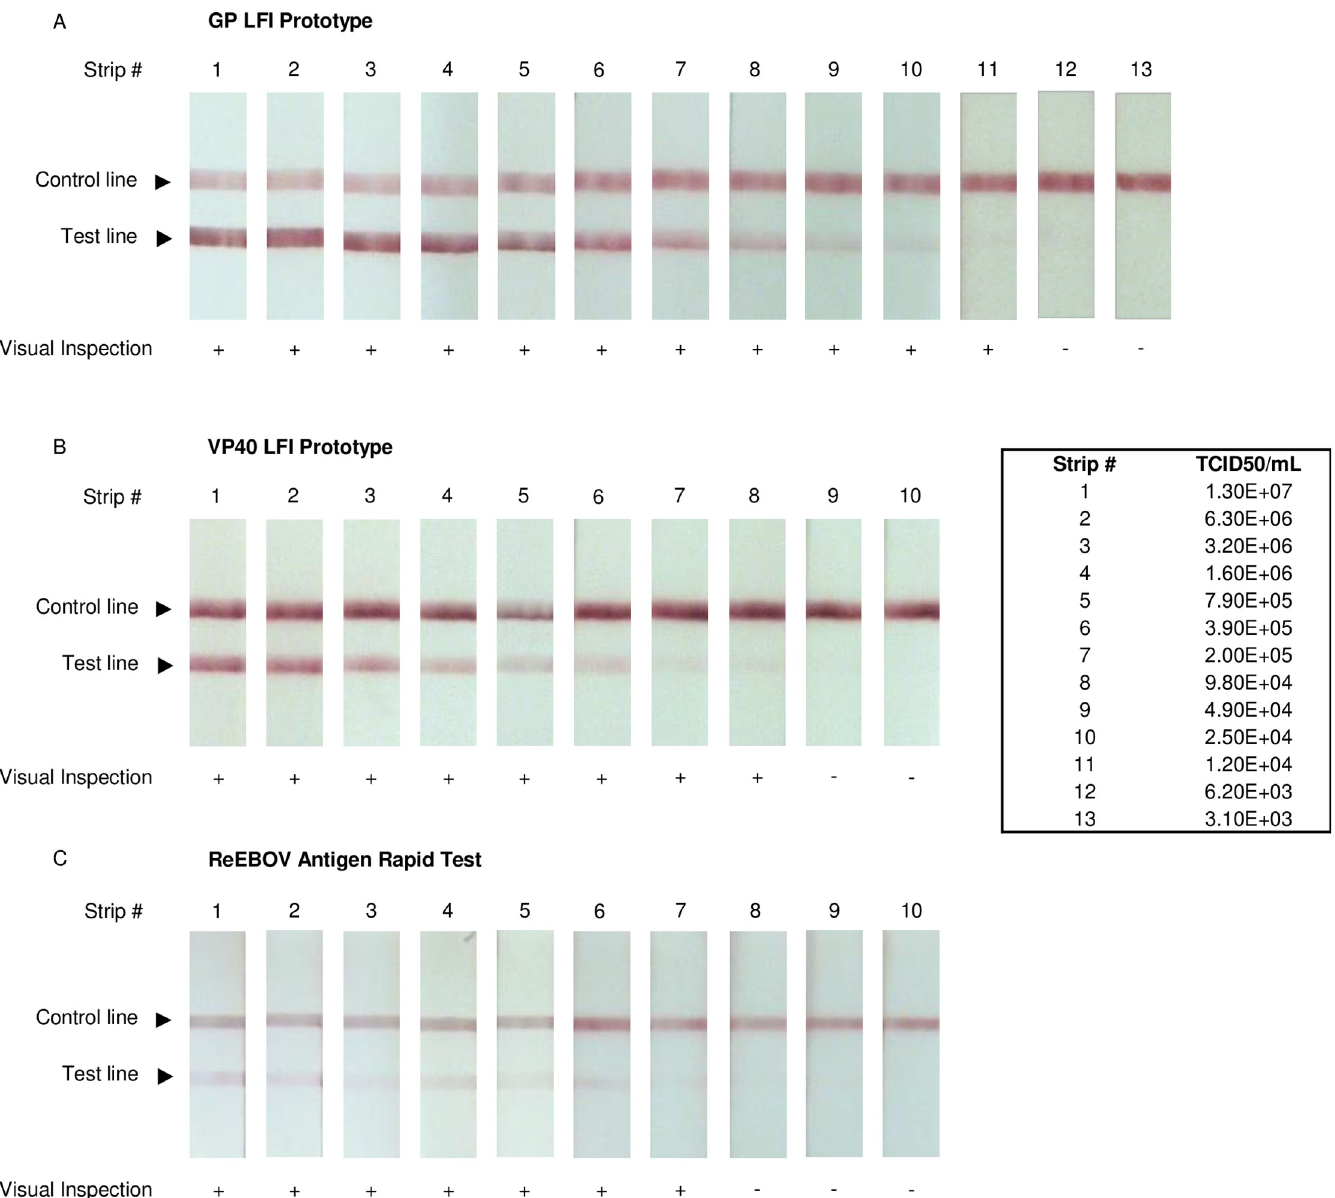
Fig 2. Sensitivity of EBOV lateral flow immunoassay (LFI) with live cultured EBOV. The GP-specific LFI prototype, VP40-specific LFI prototype and ReEBOV Antigen Rapid Test (Zalgen Labs) were evaluated for sensitivity with two-fold dilutions of EBOV (variant Makona) culture supernatant; positive (+) or negative (-) results are reported below each LFI. Viral titer of the supernatant was quantified using a TCID50